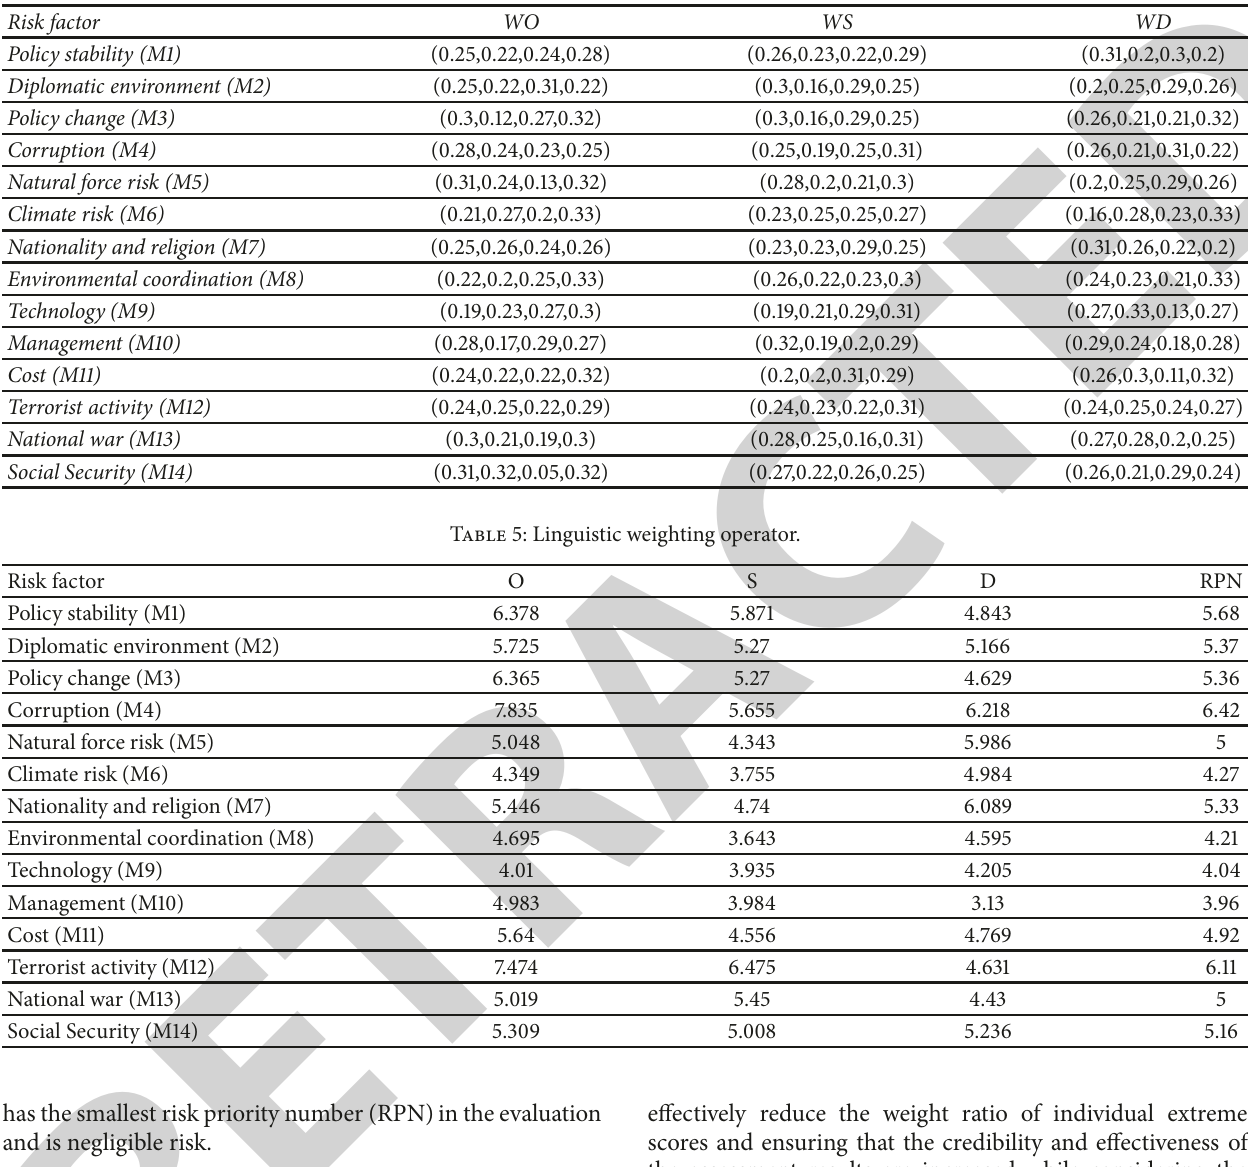
Table 4: Expert linguistic set weight coefficient.